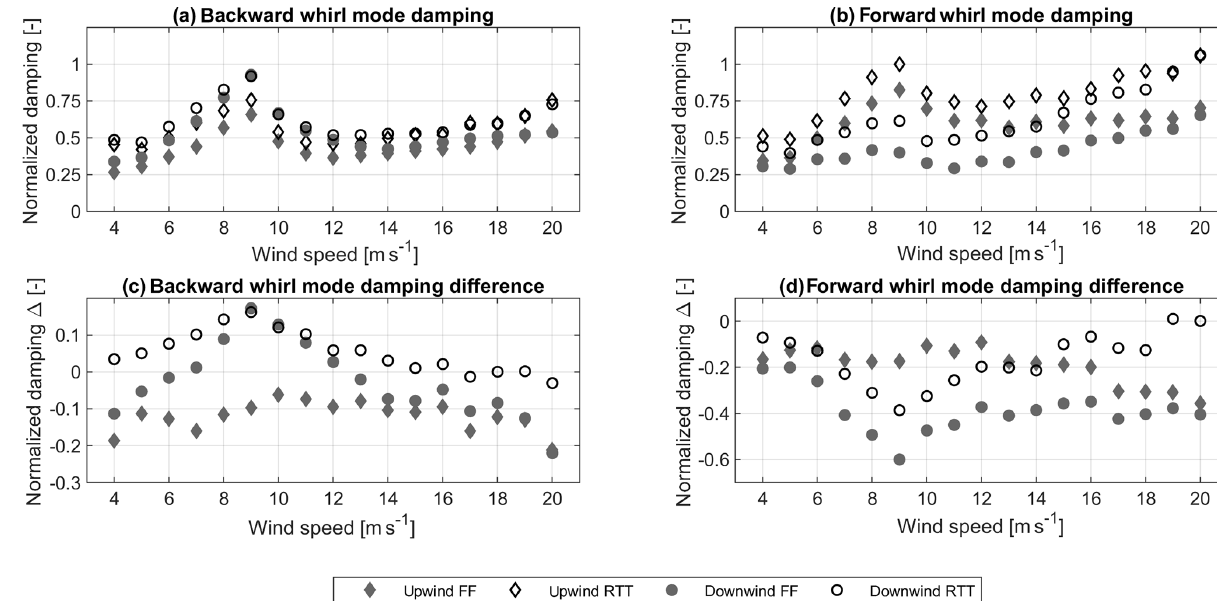
Figure 4. Normalized damping ratio as a function of wind speed for the edgewise backward whirl mode (a) and the forward whirl mode (b) for the upwind RTT and the downwind RTT configurations and the fully flexible FF configurations, as well as the difference in damping to the upwind RTT configuration in the backward whirl mode (c) and the forward whirl mode (d) . A positive difference indicates a larger damping than for the upwind RTT configuration. The damping and the damping difference are normalized with the damping of the upwind RTT configuration at 9ms − 1 of the forward whirl